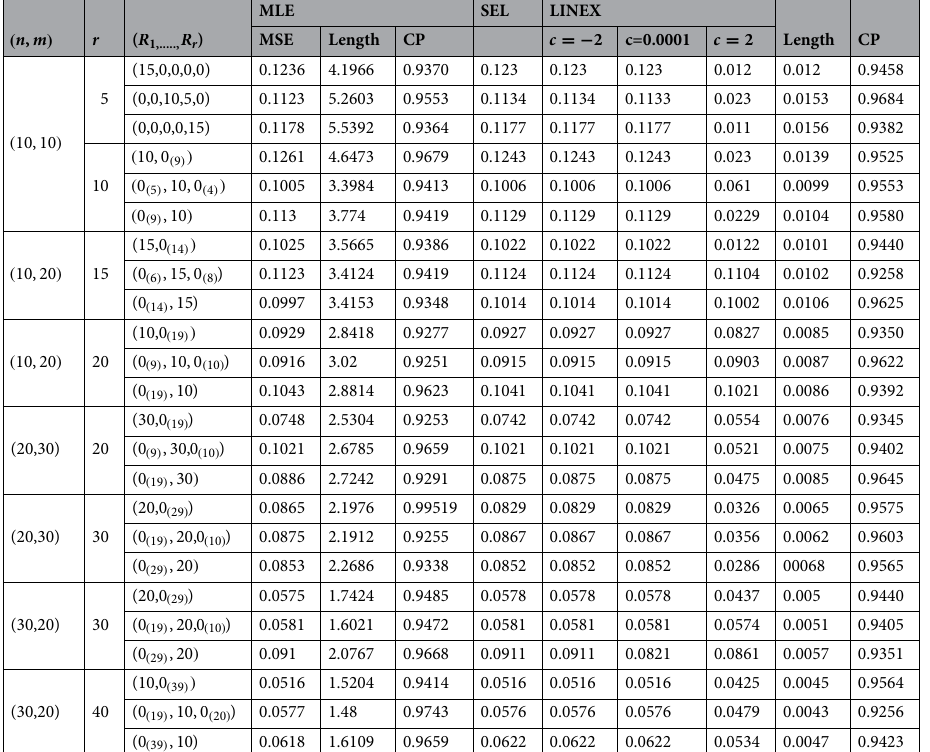
Table 7. MSE, length and coverage probability (CP) of estimates for the parameter β 1 .